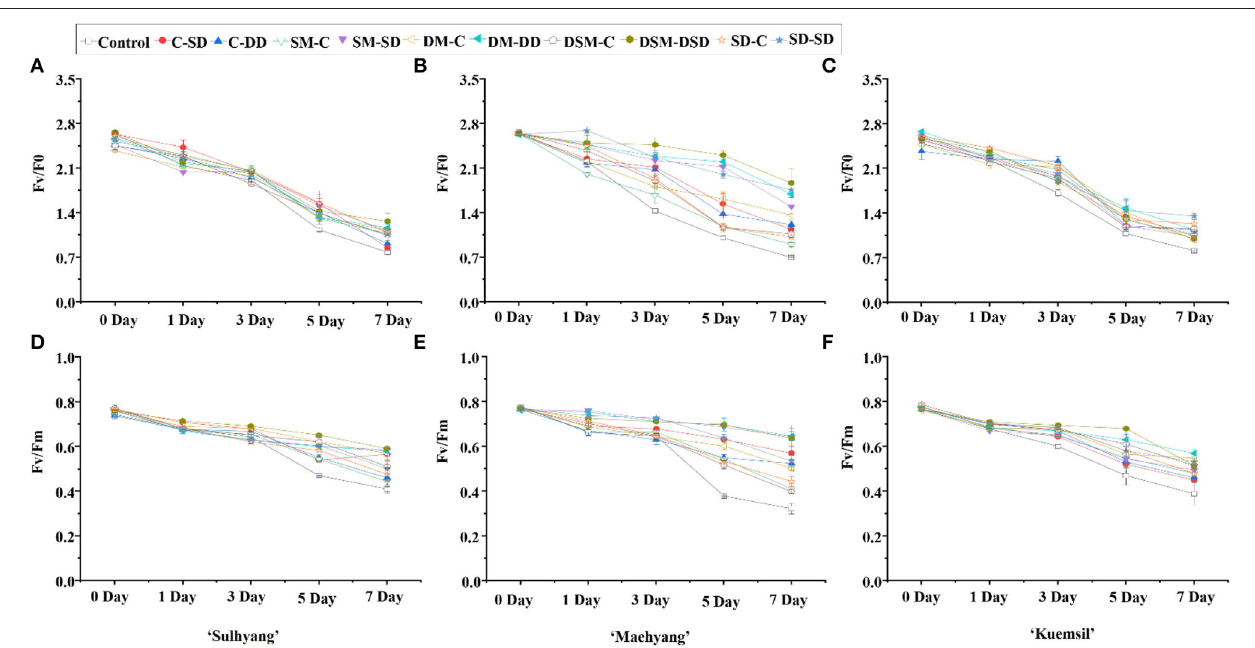
FIGURE 4 | Chlorophyll fluorescence Fv/F0 and Fv/Fm of strawberry transplants (A,D) “Sulhyang”; (B , E) “Maehyang”; and (C , F) “Kuemsil” as affected by the Si treatment after subjection to 43 ◦ C for 0, 1, 3, 5, and 7 days. See Figure 1 for descriptions of treatment codes.